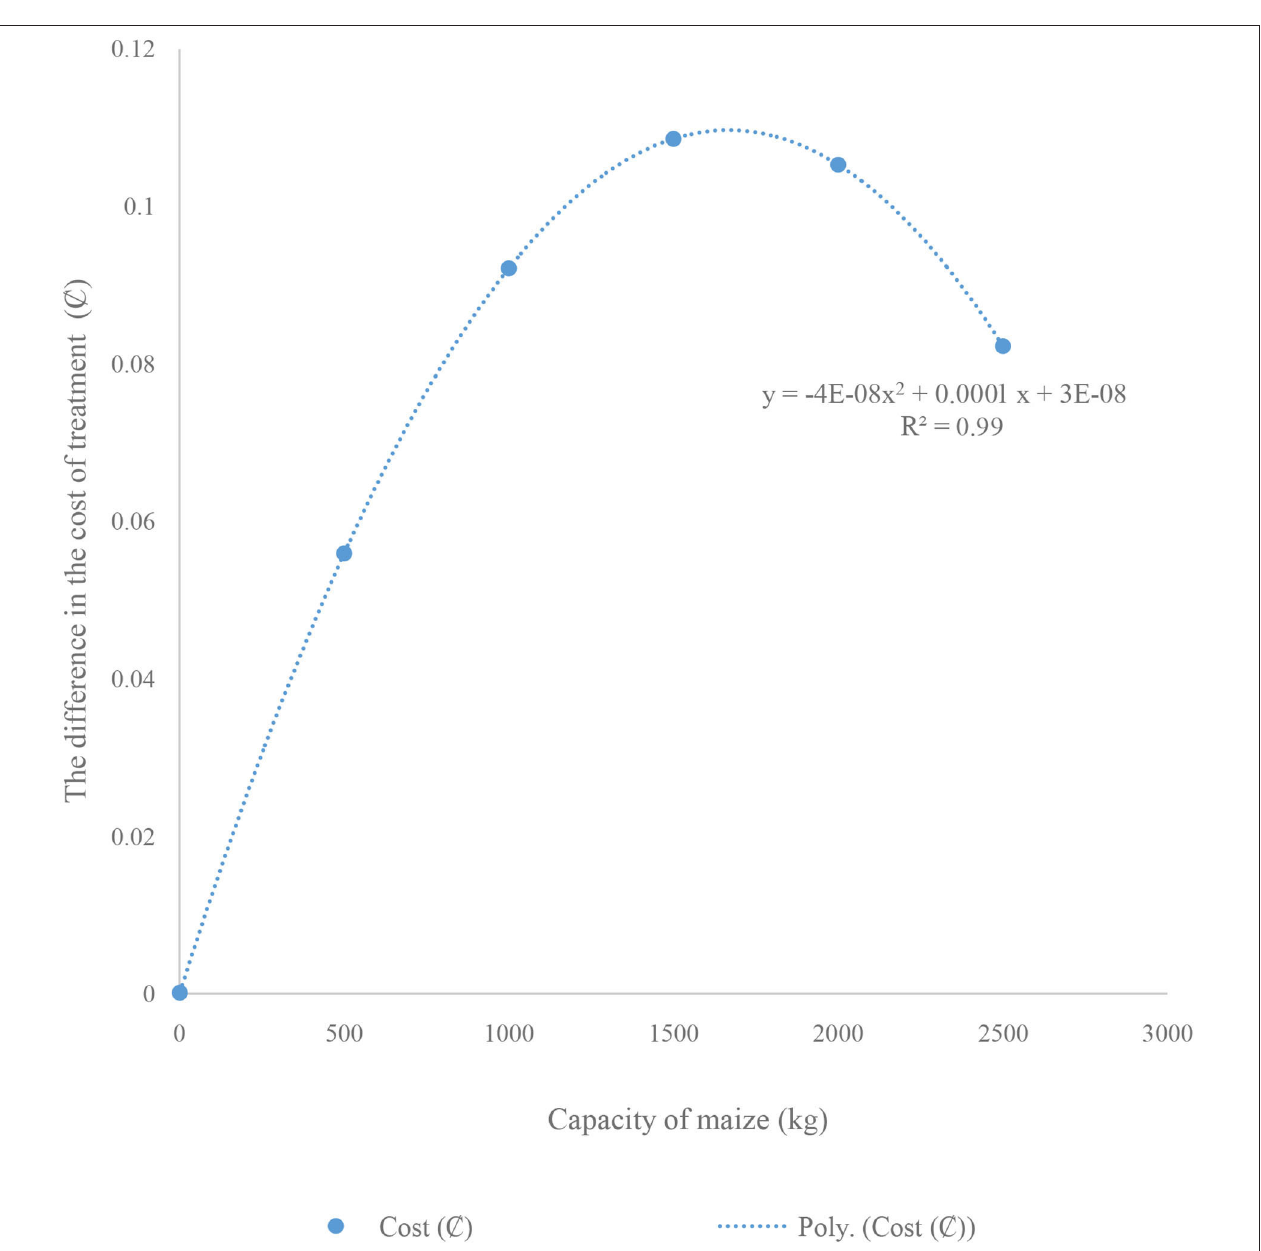
FIGURE 7 | Change in the costs of treatment by using azadirachtin and actellic super at different capacities of grains (kg) (generated using Microsoft Excel).